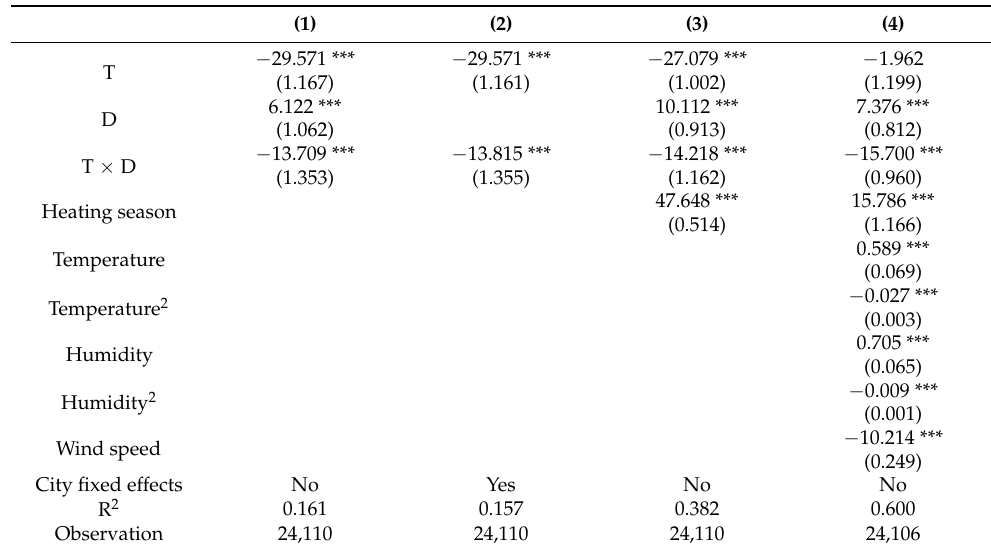
Table 1. Baseline regression